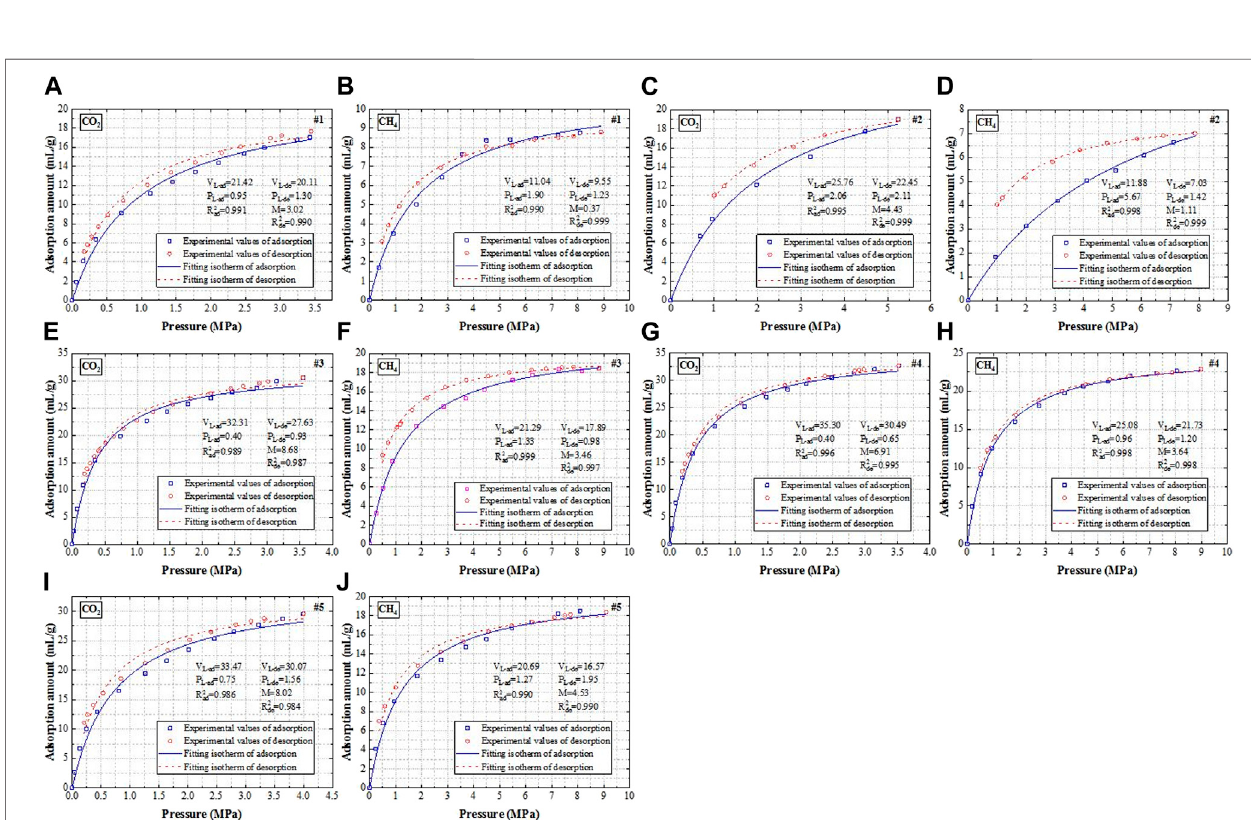
FIGURE3| Adsorptionanddesorption isothermsofCO2andCH4. (A-B) Sample#1, (C-D) Sample#2, (E-F) Sample#3, (G-H) Sample#4,and (I-J) Sample#5.